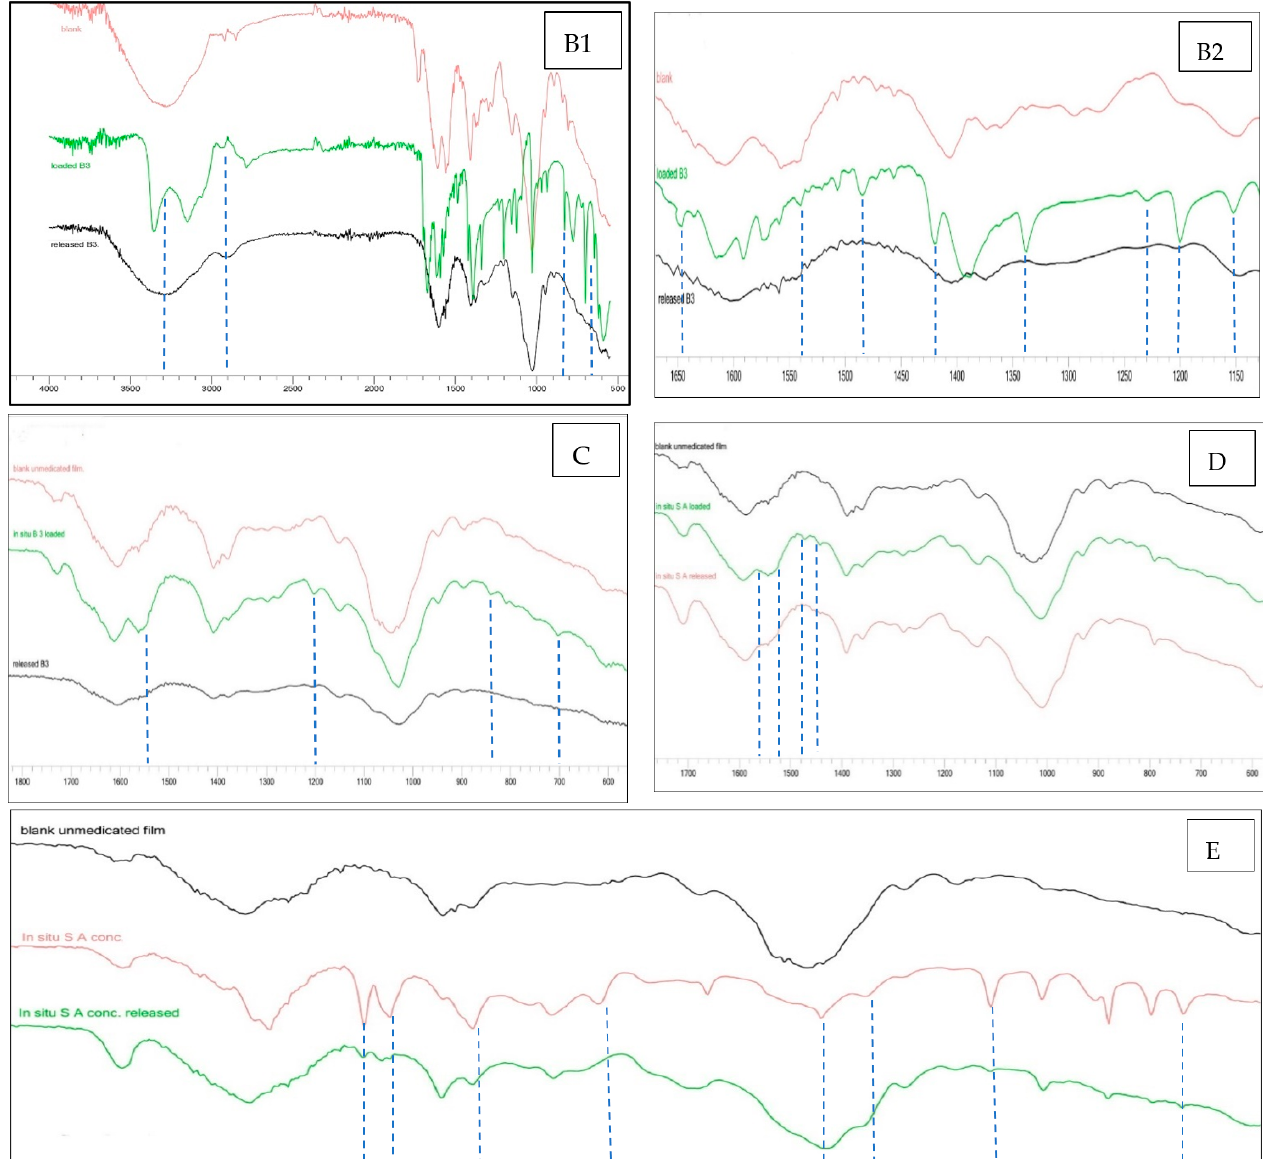
Figure 3. The FTIR spectra analysis for ( A ) compare blank unmedicated film with pure HA and pure PT, ( B1 , B2 ) post-loaded B ₃ (to compare blank unmedicated film with loaded and released film from active). ( C ) In situ loaded B ₃ profile (to compare the blank unmedicated film with active loaded and released film). ( D ) In situ 3.55% w / w SA (blank unmedicated film with active loaded and released film). ( E ) In situ 45% w / w SA (to compare blank unmedicated film with active loaded and released film).